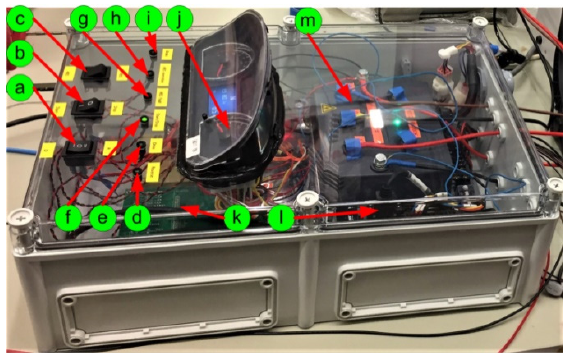
Figure 8. Prototype of developed control unit for proposed test bench.